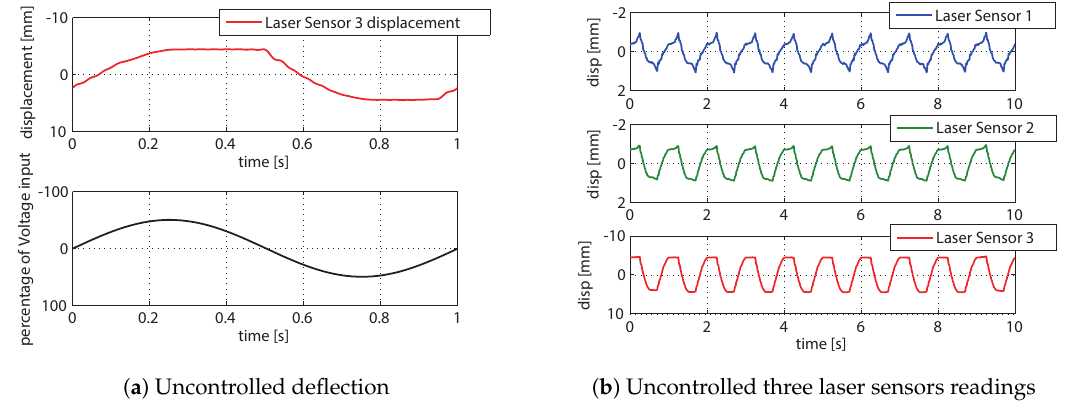
Figure 11. Uncontrolled: 1 Hz sinusoidal